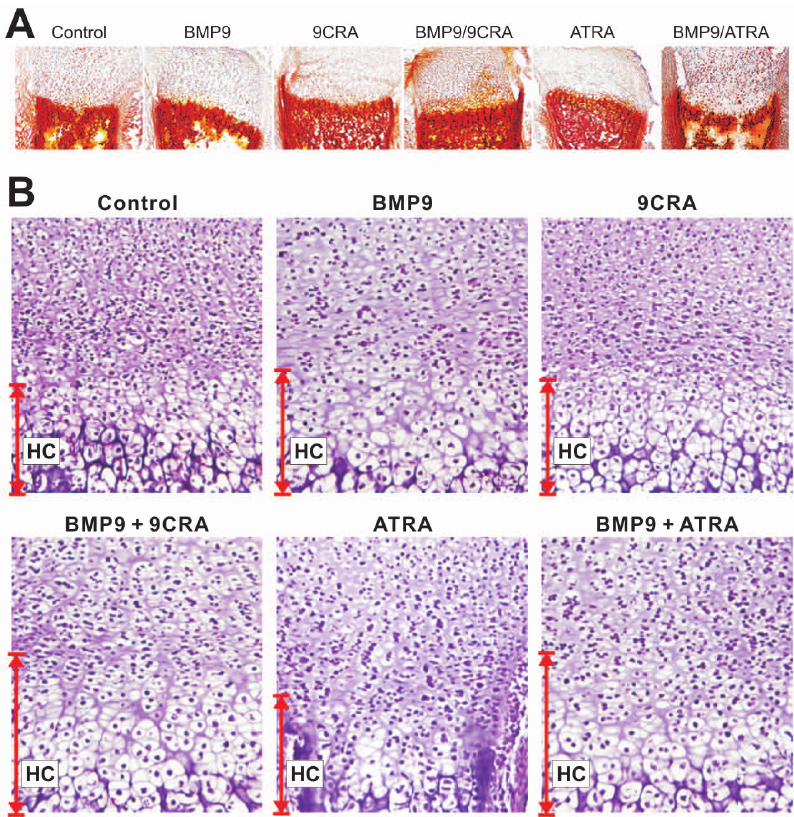
Figure 5. Retinoids and BMP9 promote the expansion of hypertrophic chondrocyte zone in organ culture. ( A ) Harvest, transduction and labeling of mouse E18.5 forelimbs (n=5 each group). E18.5 forelimbs were dissected, and the skin was removed with the soft tissues attached. Recombinant adenovirus (5 6 10 ‘ 10 pfu in 1 ml medium) expressing AdGFP or AdBMP9 added to culture medium, with or without 9CRA (20 m M) or ATRA (20 m M). After two weeks, the cultured limbs were harvested, embedded, and subjected to Alizarin Red S stating. Representative low magnification images are shown. ( B ) Histologic evaluation. The above samples were subjected to sectioning and H & E staining, and recorded under bright field with 400 6 magnification. The approximate lengths of hypertrophic zones were indicated. Representative images are shown. HC, hypertrophic chondrocyte zone.